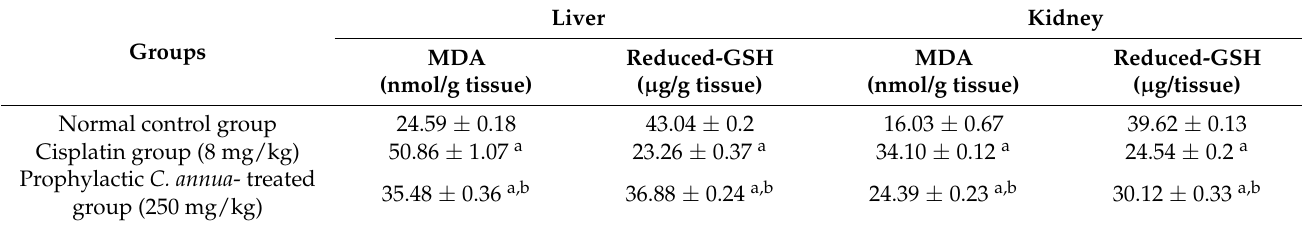
Table 2. Tissue malondialdehyde (MDA) and reduced glutathione concentrations in the studied groups.